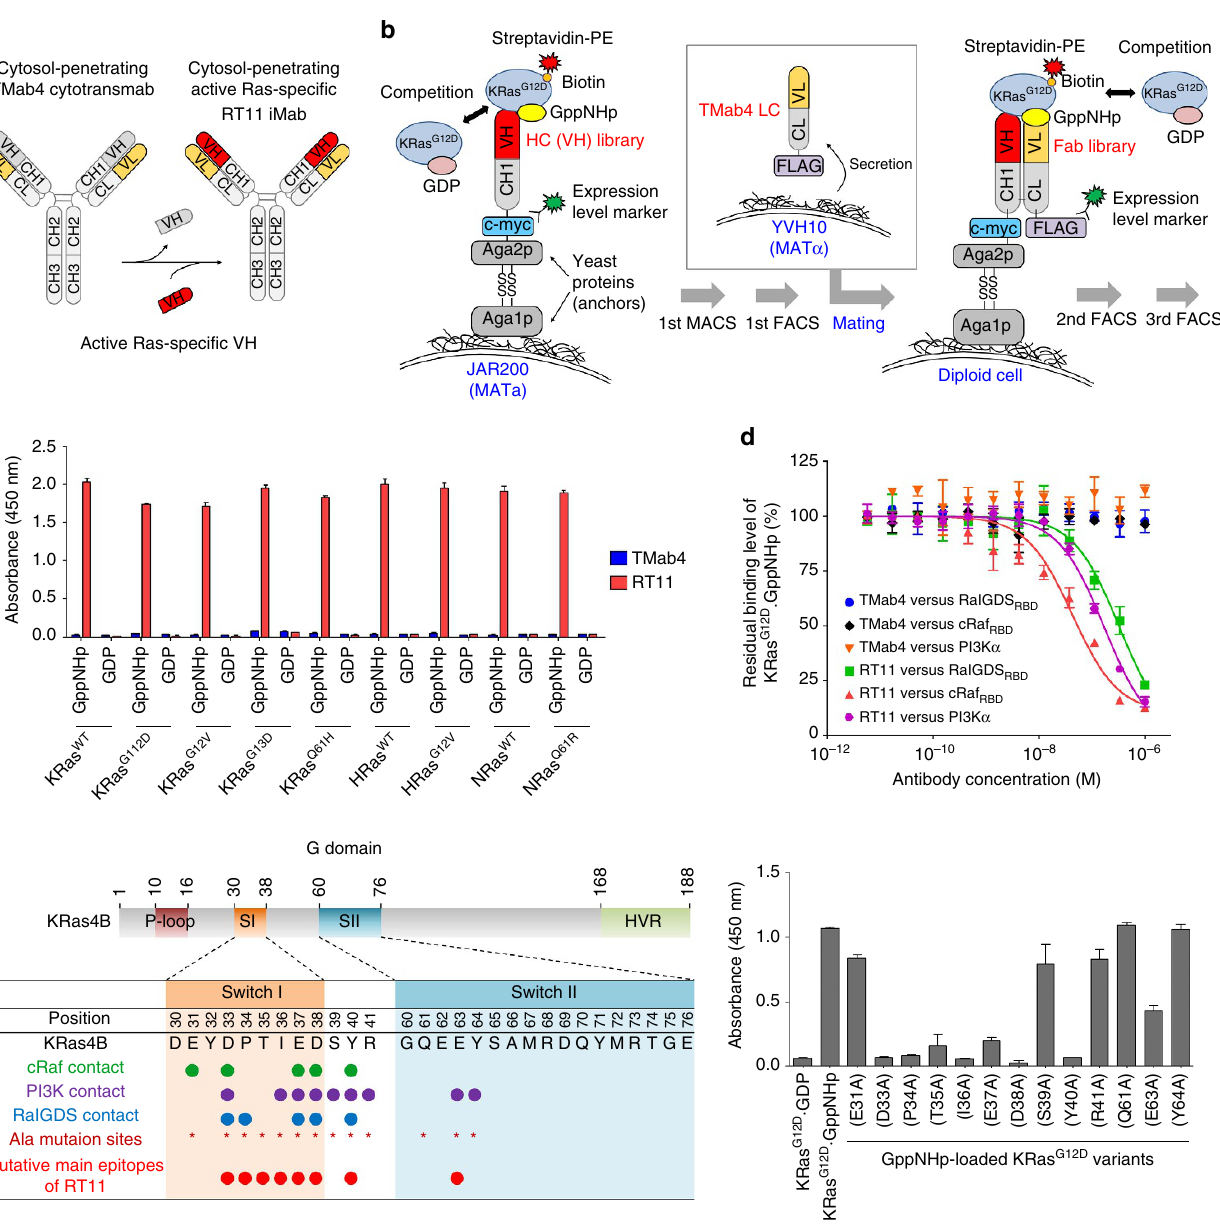
Figure 1 | Generation and characterization of active Ras specific RT11 iMab. ( a ) A strategy to generate cytosol-penetrating and GTP-bound active Ras specific antibody, RT11 iMab. ( b ) Schematic of screening method to isolate VH-dependent active Ras form-specific binding iMab antibody. ( c ) ELISA showing the selective binding of RT11, but not TMab4, to the GppNHp-bound active form of the representative oncogenic Ras mutants over the GDP-bound inactive form. ( d ) Competition ELISA showing that RT11, but not TMab4, blocks interactions between KRas G12D (cid:2) GppNHp and effector proteins, such as cRaf RBD , RalGDS RBD , and PI3K a (p110 a /p85 a ). ( e ) Epitope mapping of RT11 by alanine-scanning mutagenesis. (Right) ELISA showing the binding of RT11 to KRas G12D alanine mutants. (Left) Comparison of the KRas4B residues directly involved in the interactions with cRaf 61 , PI3K 30 , and RalGDS 62 with the putative main epitopes (red circle) of RT11, determined by alanine-scanning mutagenesis. In c – e , error bars represent the mean ± s.d. ( n ¼ (RalGDS RBD ), as well as PI3K a (p110 a /p85 a ), for binding to KRas G12D (cid:2) GppNHp (Fig. 1d), suggesting that RT11 binds to the PPI interfaces between active Ras and effector proteins.